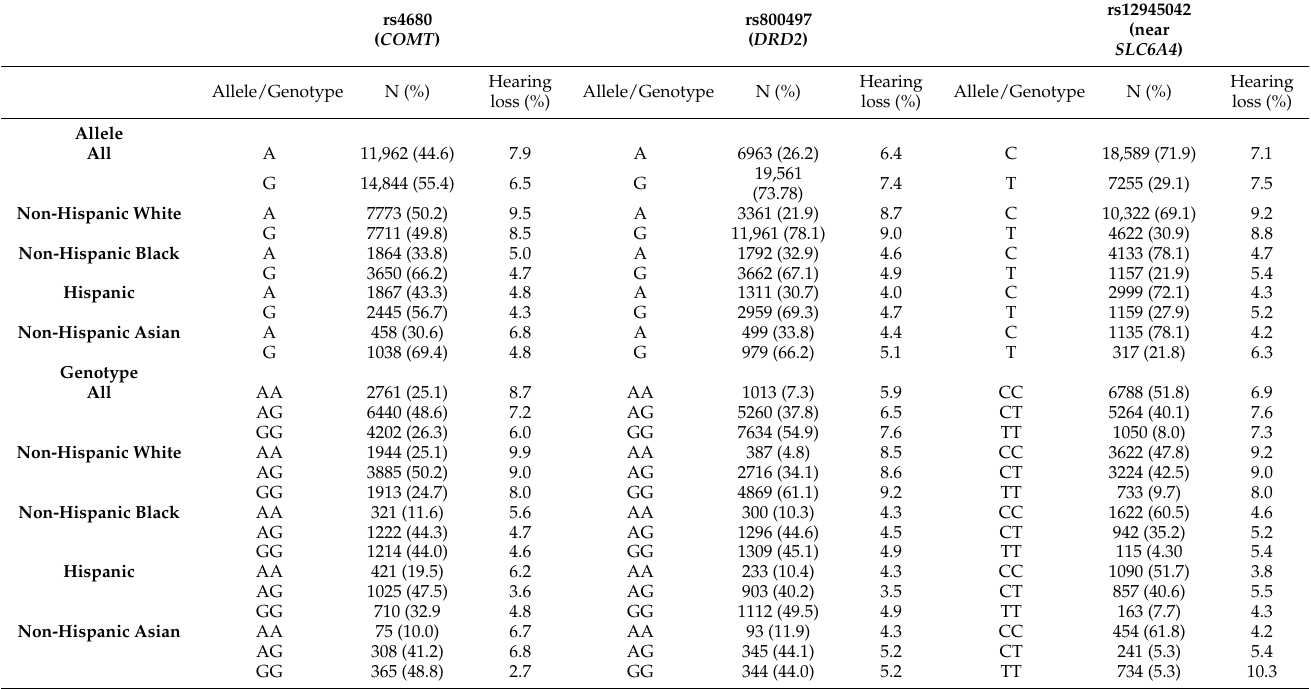
Table 2. Frequencies of allele and genotype in rs4680, re800497, and rs12945042 and prevalence